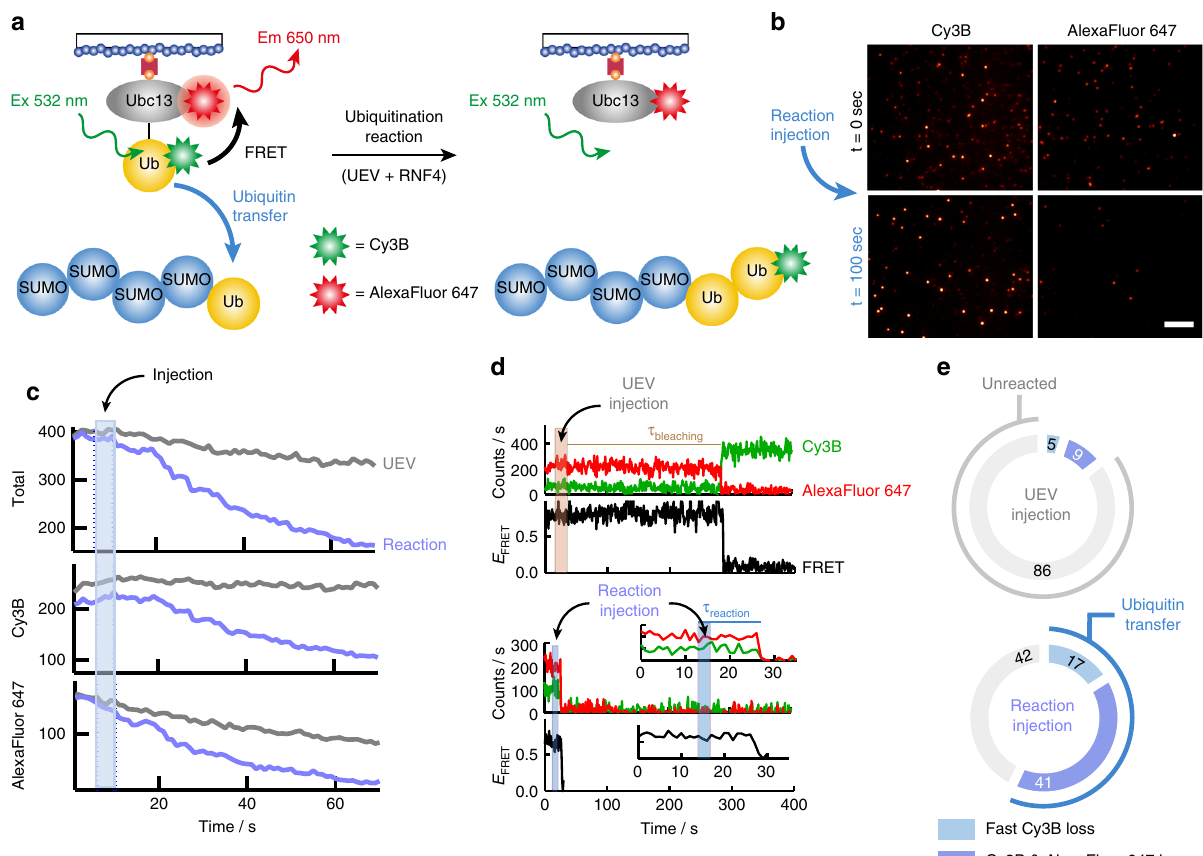
Fig. 4 Single ubiquitination events revealed by real-time smFRET. a Schematic diagram showing real-time ubiquitination reaction results in loss of FRET between the Ubc13~Ub conjugate and transfer of Cy3B-labelled ubiquitin on to the substrate that diffuses into solution. Excitation (Ex) and emission (Em) wavelengths are highlighted. b Images of Cy3B and AlexaFluor 647 channels taken before ( t = 0 s, black) and after ( t = 100 s, blue) the injection of reactants showing loss of both the Cy3B signal and the FRET signal from AlexaFluor 647 during the real-time smFRET experiment. The scale bar represents 10 μ m. c Comparison of cumulative intensity variation from all fl uorescent spots over time for UEV only injection (grey) versus reaction injection (blue). The total fl uorescence intensity is shown along with separate Cy3B and AlexaFluor 647 intensities, with the injection interval highlighted in blue. d Comparison of representative single molecule traces for the UEV injection (top) and reaction injection (bottom). Each molecule contains a Cy3B, AlexaFluor 647 and FRET intensity trace. The injection interval for the UEV injection (brown) and the reaction injection (blue) is highlighted. The lifetime of AlexaFluor 647 before photobleaching ( τ bleaching ) is highlighted in brown for the UEV injection. The inset shows the fi rst 35 s of the reaction injection, highlighting in blue the simultaneous loss and short lifetimes ( τ reaction ) of the Cy3B, AlexaFluor 647 and FRET signals. e Charts showing the percentage contribution of unreacted molecules (grey) and molecules undergoing ubiquitin transfer (Cy3B loss in light blue, Cy3B and AlexaFluor 647 loss in dark blue) to the overall population, representing n = 263 and 270 individual molecules for the UEV and reaction injection respectively. Source data are provided as a Source Data fi